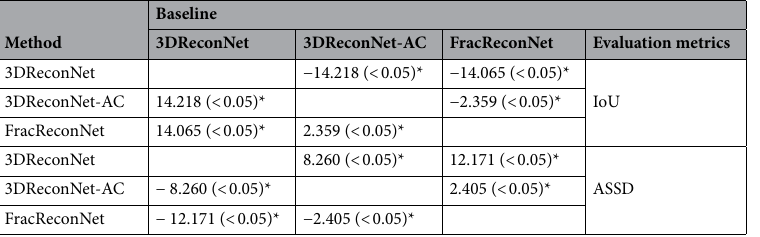
Table 3. T-score (P-value) using paired T-Test method comparing various methods. The methods include 3DReconNet, 3DReconNet-AC, and FracReconNet, which are compared based on mIoU and mASSD evaluation metrics. Note that * represents a significant difference measured by p-value. *Significate difference at 95% confident interval of p-value <